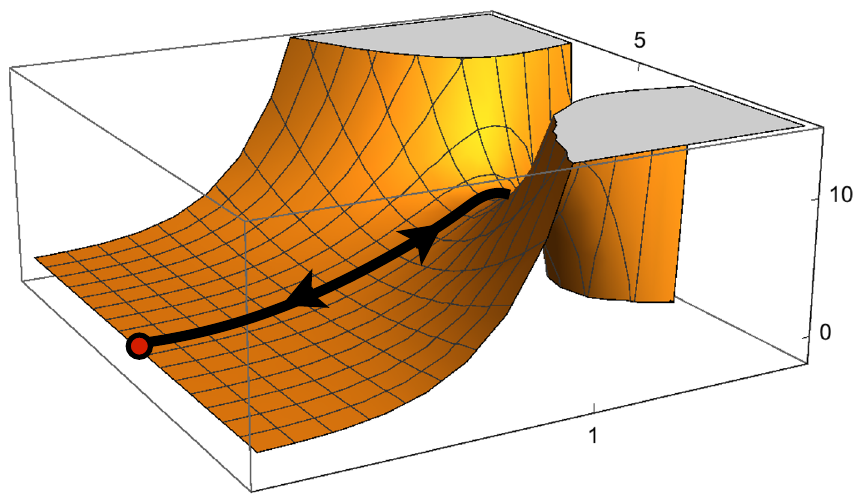
Figure 1 . NS5 potential in the non-supersymmetric case, and path of the